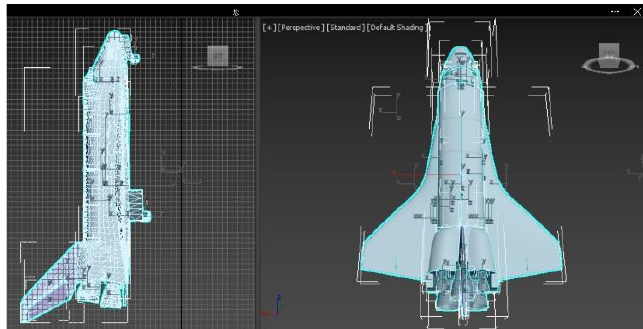
Figure 2. Development of 3D objects in the VR system.